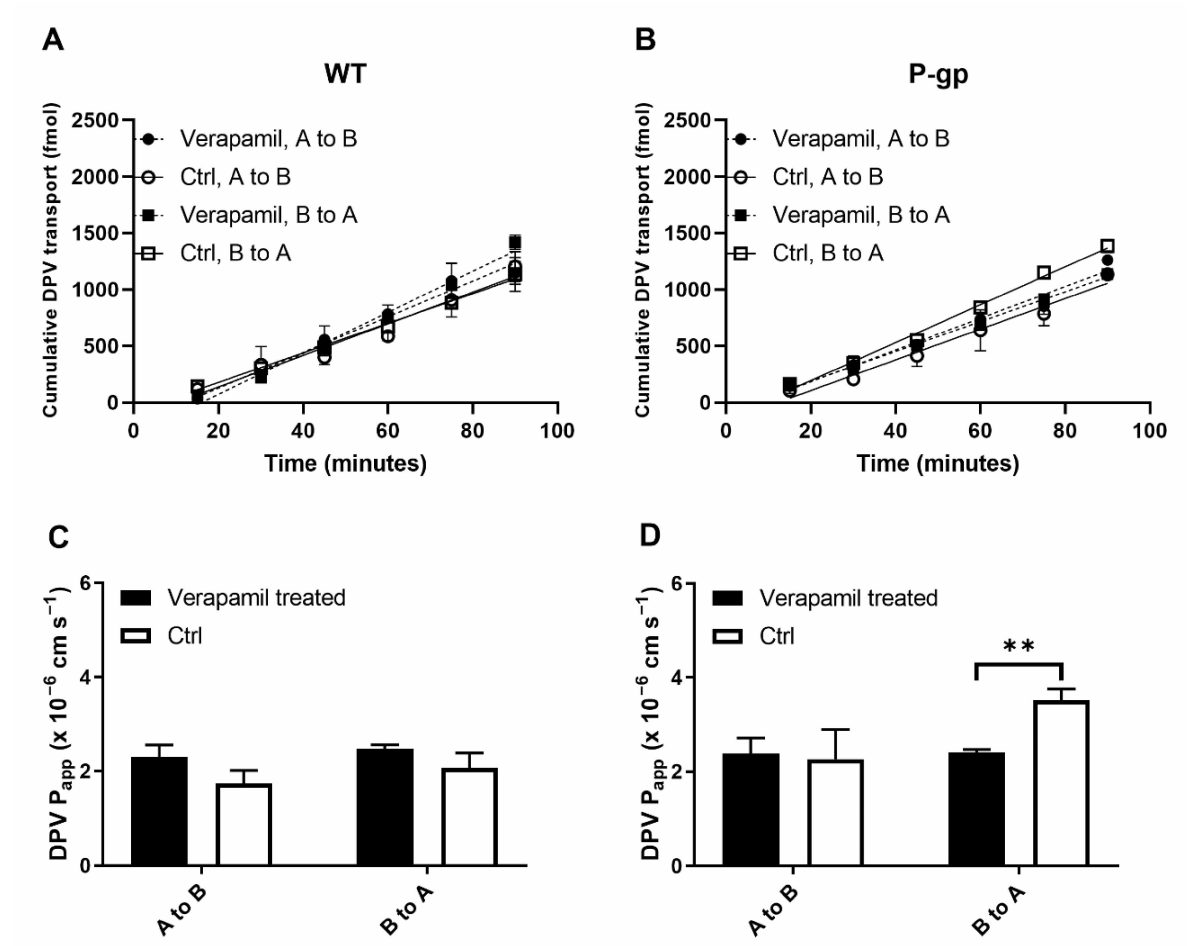
Figure 2. DPV bi-directional transport across MDCKII WT ( A ) and P-gp ( B ) cell monolayers with and without the transporter inhibitor, verapamil; P app values obtained from the transport assays ( C , D ). Data represented as mean ± SD of three biological replicates. ** p < 0.01 (Student’s t -test). The linear transport of DPV across MDCKII BCRP and WT/EV cell monolayers is shown in Figure 3. The flux of DPV showed few directional differences and was not affected by the inhibitor, Ko143 (Figure 3A,B). In addition, the DPV P app values had no directional difference and were not affected by Ko143 (Figure 3C,D). The calculated net flux ratio was 1.33. The ER in MDCKII BCRP cells was reduced to 85% by Ko143. No significant difference was observed in the A to B P app and B to A P app of mannitol with and without the presence of Ko143 (Figure